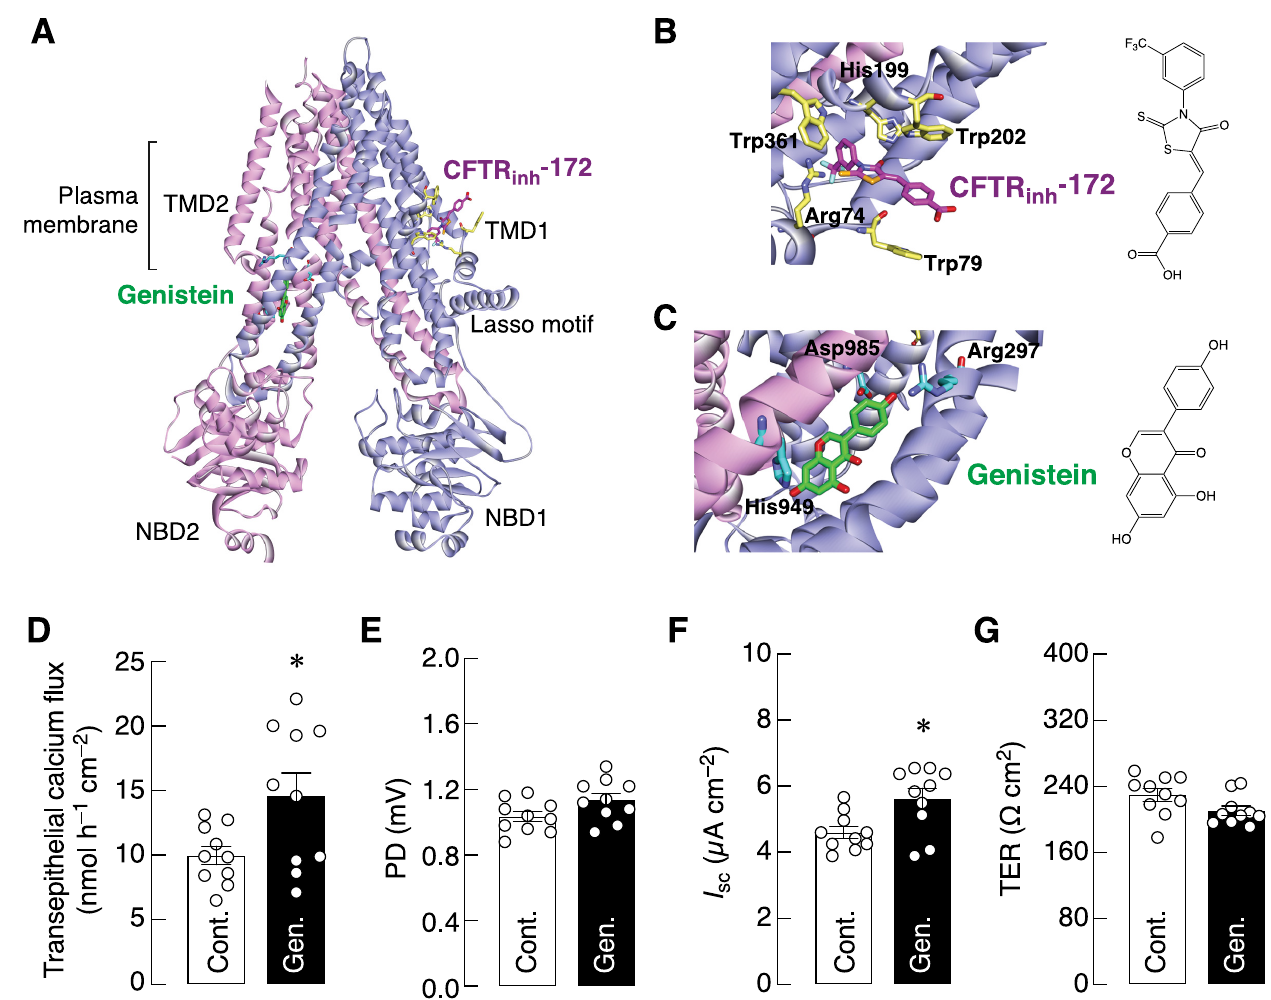
Fig 5. In silico molecular docking and the effects of CFTR activator (genistein) on transepithelial calcium transport. (A) The architecture of CFTR and location of the proposed CFTR inh -172 (magenta)- and genistein (green)-binding pockets. (B) CFTR inh -172 (magenta) surrounded by His199-Arg74-Trp79-Trp202-Trp361 (yellow) resembles the thiazolidinyl ring’s binding interaction from the PDB ID: 4JIR and PDB ID: 4JIH. (C) Genistein (green) was docked to the Arg297-Asp984/5-His949 motif (cyan) in the orientation found in PDB ID: 1X7J. (D) Transepithelial calcium flux and (E–G) epithelial electrical parameters (PD, I sc , and TER) across Caco-2 monolayers directly exposed to 50 μ M genistein (Gen.) on the apical side for 30 min. � p < 0.05 vs. control group (open bar, unpaired Student’s t -test).